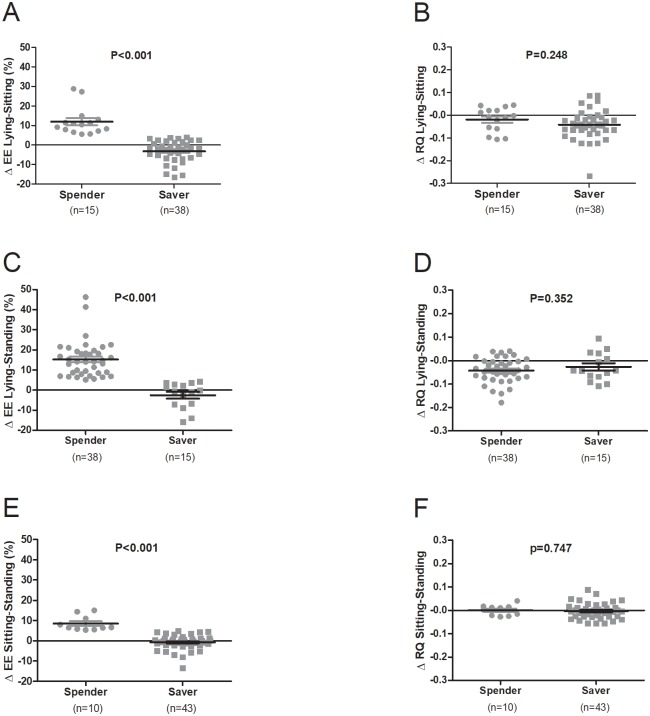
R individual energy expenditure (EE; Panels A, C, and E) and respiratory quotient (RQ; Panels B, D, and F) responses of lying vs. sitting position (Panels A and B), lying vs. standing position (Panels C and D) and sitting vs. standing position (Panels E and F) comparing spenders vs. savers.Spenders were defined as participants who showed a rise in EE >5% between two positions and savers are those who showed little or no change in EE (a rise in EE of <5% between two positions). Δ EE was calculated as the change in EE during the second 5 minutes corresponding to the two positions compared, and it is expressed as a percentage of the first position indicated for each comparison. Δ RQ was calculated as the change in RQ during the second 5 minutes corresponding to the two positions compared, and it is expressed as means ± standard deviation.